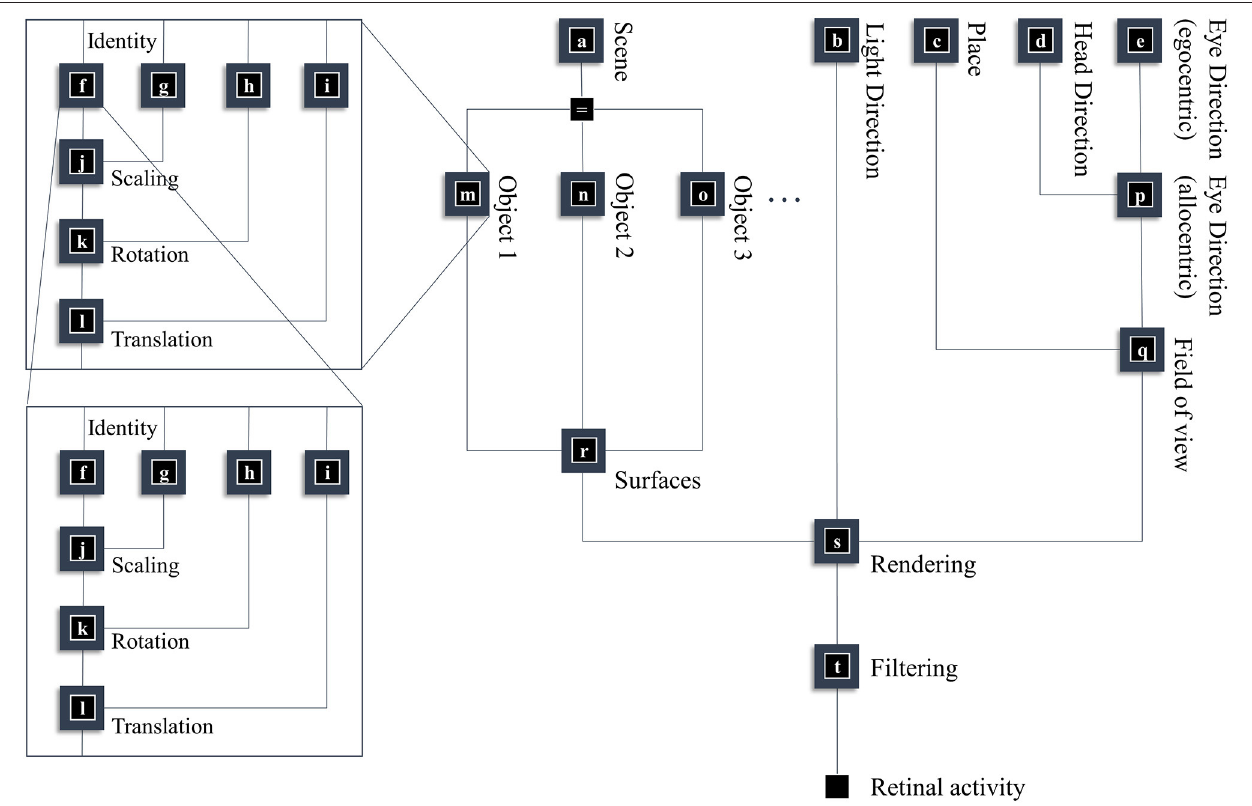
FIGURE 1 | A generative model for seeing. This figure offers a summary of a model that generates a retinal image. Starting from the scene in which we find ourselves, we can predict the objects we expect to encounter. These objects may be recursively defined, through identifying their constituent parts and performing a series of geometric (affine) transformations that result in the configuration of parts, the scaling and rotation of this overall configuration, and the placement of these objects in an allocentric reference frame. The nested parts of the graphical structure (on left hand side) indicate this recursive aspect, e.g., an object is defined by an identity, and scaling, rotation and translation parameters; furthermore, it may be composed of various sub-objects each of which has these attributes. To render a retinal image, we also need to know where the retina is and which way it is pointing (i.e., the line of sight available to it). This depends upon where we are in the environment, our heading direction, and where we choose to look. Subsequent figures unpack the parts of this model in greater